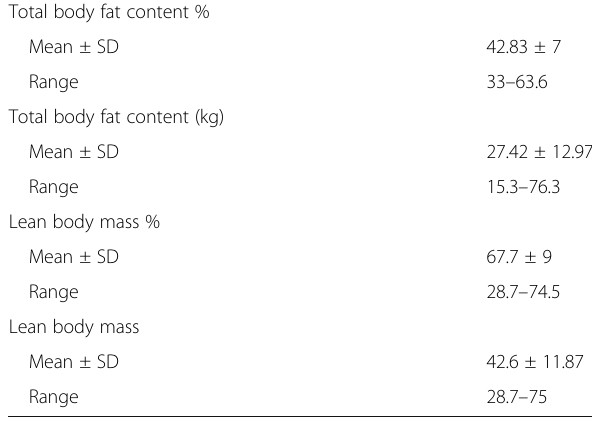
Table 2 Body fat versus lean body mass in obese